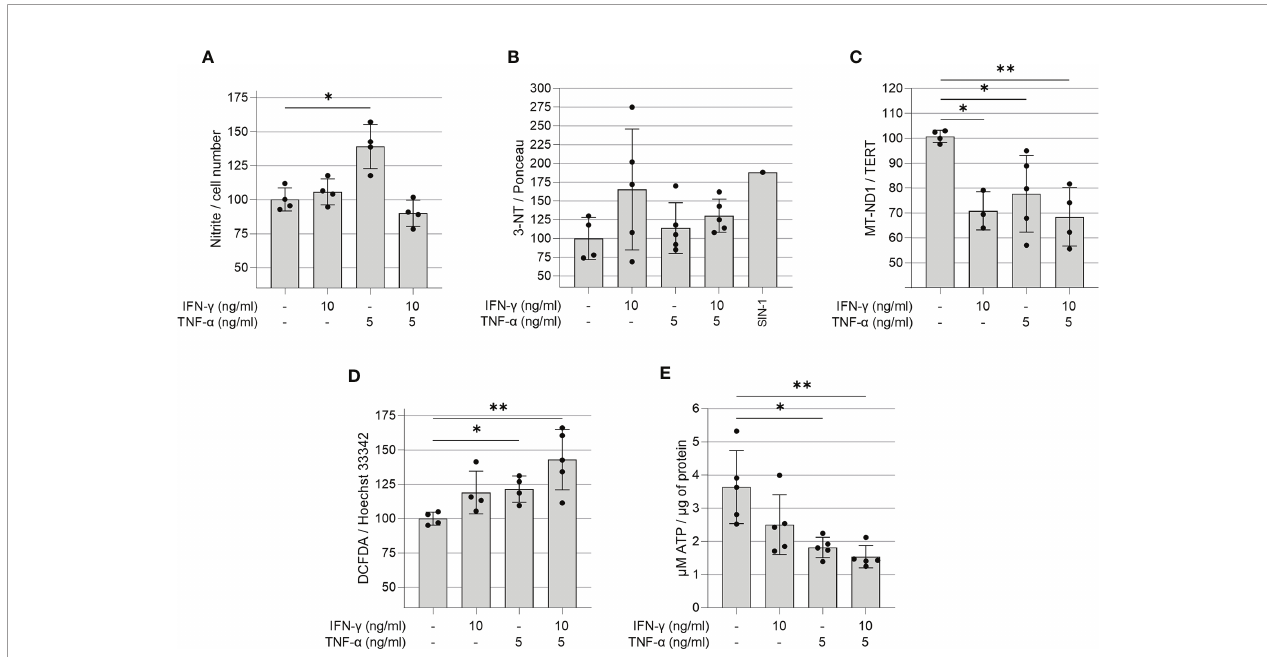
FIGURE 3 | Quanti fi cation of ROS, RNS, ATP and mitochondrial DNA in IFN- g and TNF- a stimulated AC-16 cells. Human cardiomyocytes AC-16 cells were stimulated with 10 ng/ml of IFN- g , 5 ng/ml of TNF- a or both for 48h. Then, cell lysates were used for the quanti fi cation of (A) nitrite (µM) by Griess Reaction; (B) 3-nitrotyrosine by dot blot; (C) copy number of the mitochondrial gene MT-ND1 by real time PCR; (D) cellular reactive oxygen species (ROS) by fl uorescence assay using the probe DCFDA and (E) ATP by luciferase-based assay. Data are shown as percentage to not-stimulated cells in (A – D) *p < 0.05; **p < 0.01; one- way Anova Dunn ’ s post test. Each dot represents an independent experiment n ≥